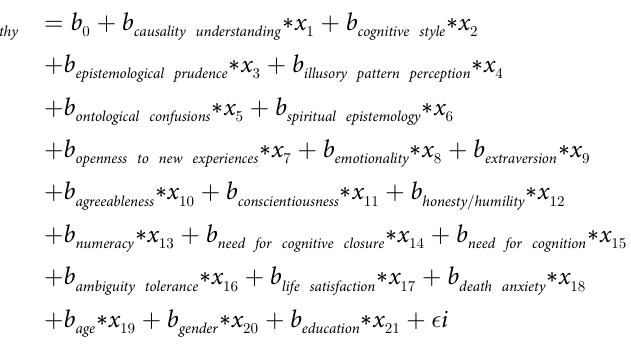
Table 2 displays the results for both regression analyses. The predictor model explained 20.2% of the variance in CAM belief, indicating a high goodness-of-fit [67]. Ontological confusions and spiritual epistemology correlated positively with the criterion. Also, agreeableness and death anxiety were both significant predictors of CAM belief and as well positively correlated. Gender, as a socio-demographic variable, was also positively correlated with CAM belief.